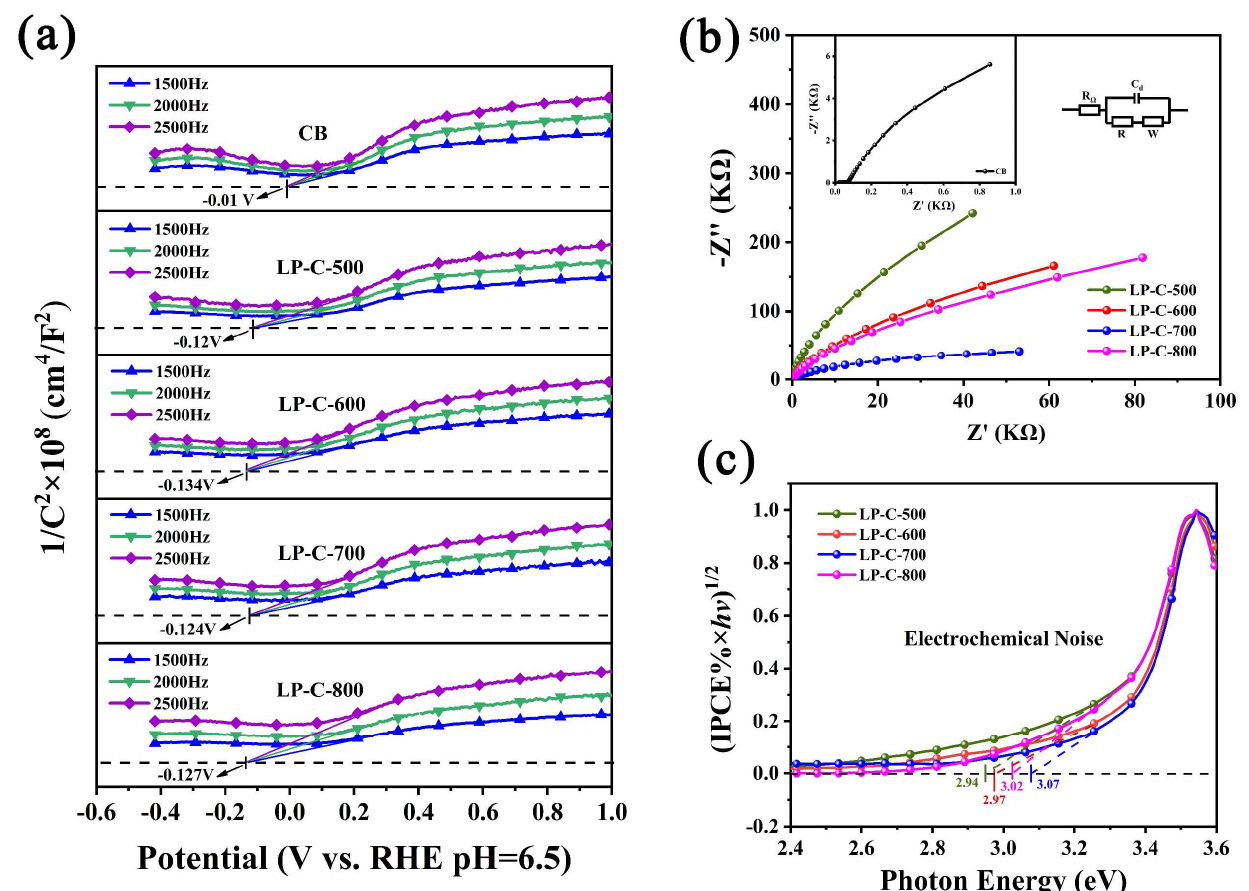
Figure 9. ( a ) Mott − Schottky plots, ( b ) electrochemical impedance spectroscopy (EIS), and ( c ) the band gap determination extracted from IPCE spectra by a function of (IPCE % × h ν ) 1/2 vs. photon energy of samples.